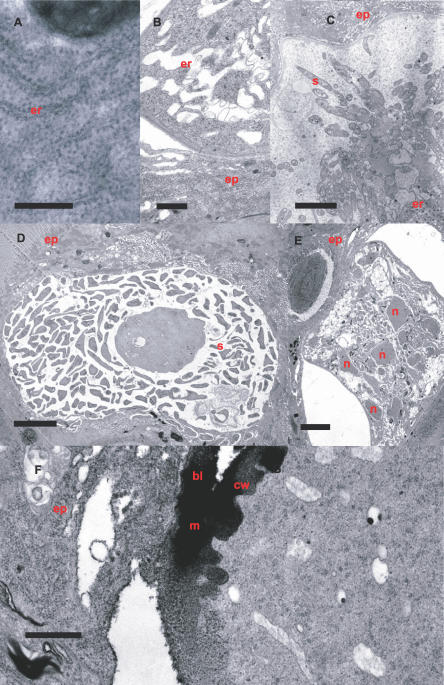
Transmission Electron Micrographs of wt and Δpblap OocystsAll images taken on day 13 p.i. unless otherwise indicated. Scale bar = 1 μm (A, B, F) or 5 μm (C–E). ep, midgut epithelium.(A) wt oocyst showing normal morphology of the endoplasmic reticulum (er).(B) Δpblap2 oocyst showing extensive expansion of the endoplasmic reticulum (er).(C) Δpblap1 oocyst (day 27 p.i.) showing extensive expansion of the endoplasmic reticulum (er) and some budding sporozoites (s).(D) wt oocyst showing normal morphology following cytokinesis to produce hundreds of daughter sporozoites (s).(E) Δpblap2 oocyst showing extensive degeneration and few nuclei (some of which are labelled n).(F) Degenerate Δpblap4 oocyst showing prominent melanization (m) of the extracellular oocyst wall (cw) which appears to spread into the mosquito basal lamina (bl).